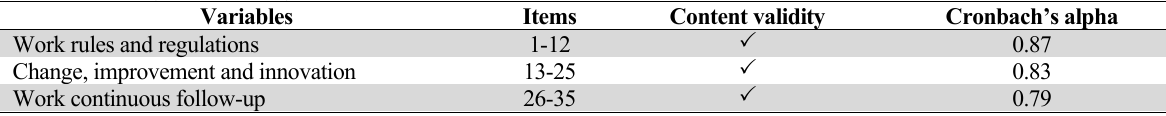
Results of validity and reliability